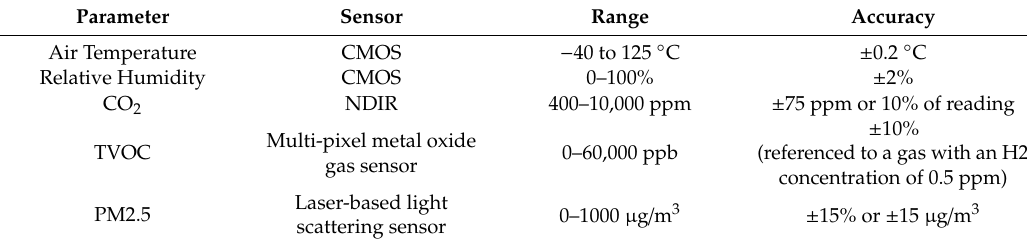
Table A1. Characteristics and uncertainty of the sensors used for on-site